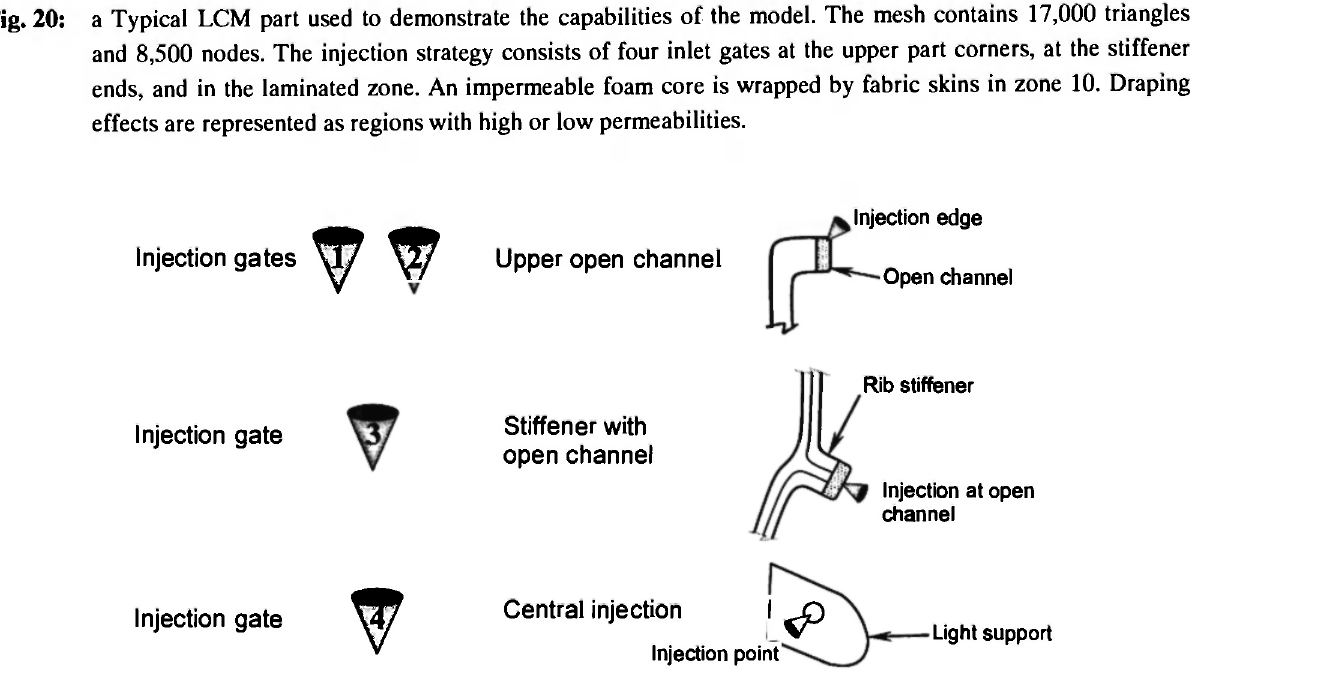
Injection strategy used for the truck fender. Four injection gates are set in the mold. Open channels are used for a better distribution of the resin flow. To ensure filling of the stiffener, an open channel is created at the extremity of the